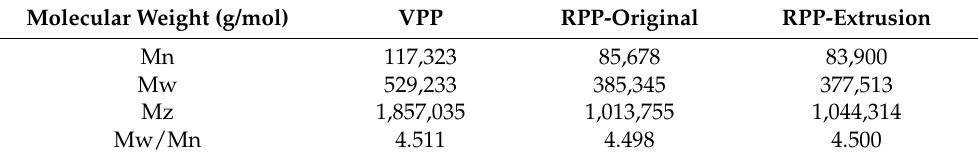
Figure 6. HT-GPC chromatogram of VPP, RPP-original, and RPP-extrusion. Table 3. Molecular weight and molecular weight distribution of VPP, RPP-original, and RPP-extrusion.